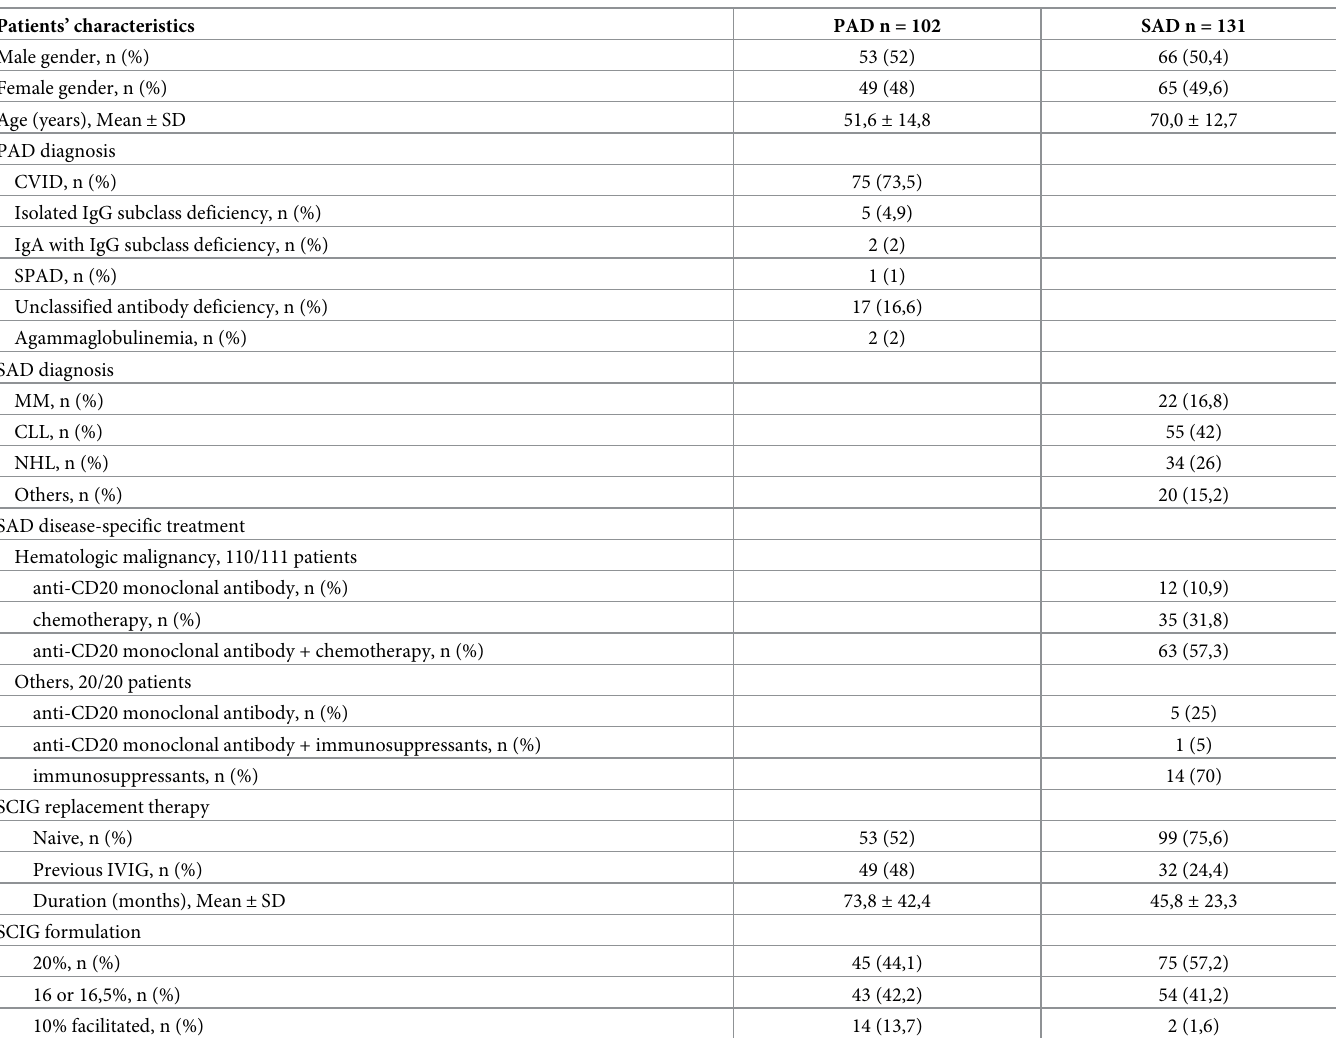
Table 1. Demographics and clinical history of PAD and SAD patients. Patients’